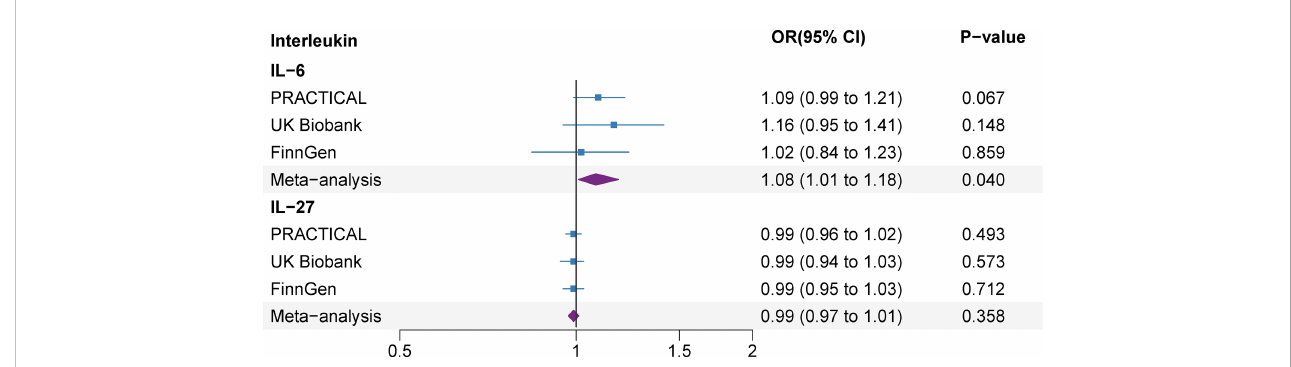
FIGURE 4 Associations of genetically predicted circulating interleukin levels with prostate cancer after the exception for body mass, smoking and high cholesterol. IL, interleukin; OR, odds ratio; CI, con fi dence